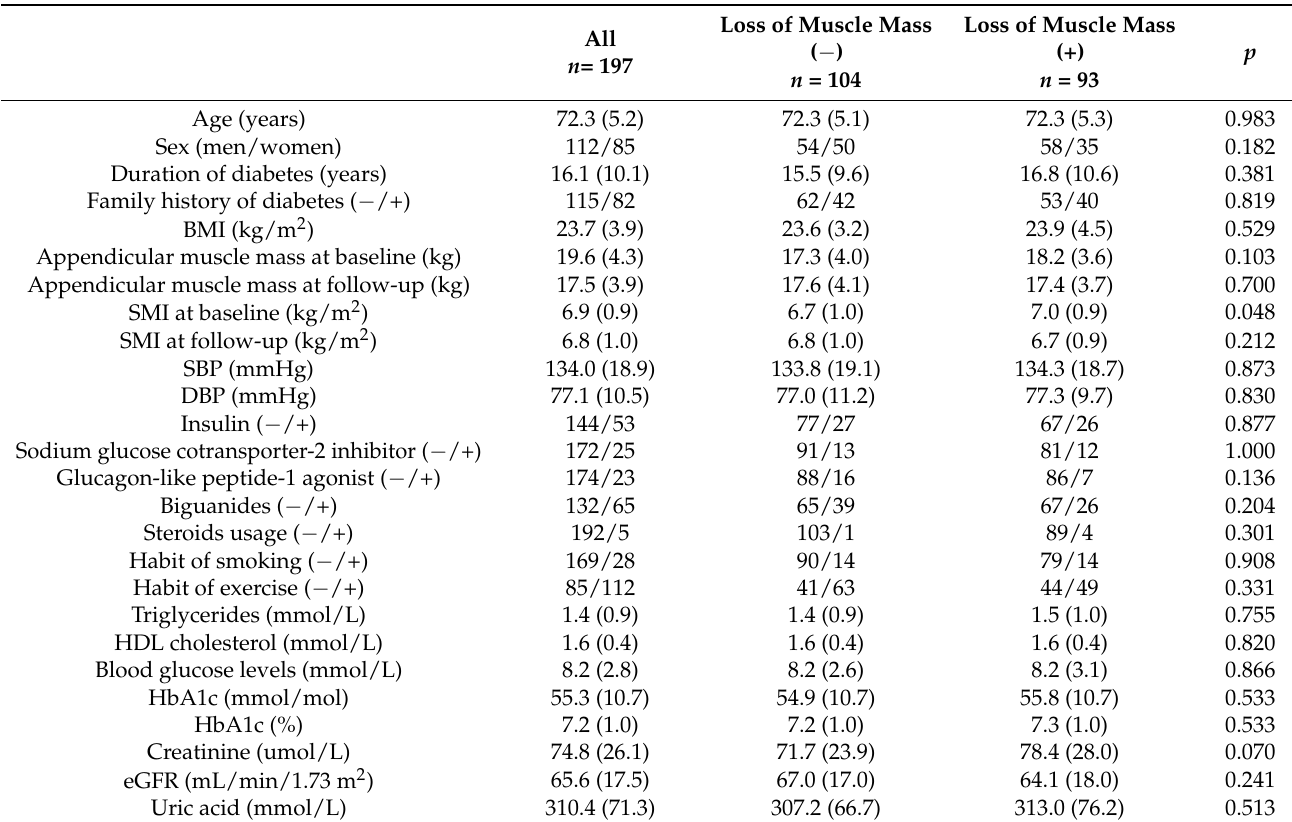
Table 1. Of the participants, 47.2% ( n = 93/197) developed the loss of muscle mass at the 13.7 ± 5.2 month follow-up. Table 1. Clinical characteristics at baseline of study participants.